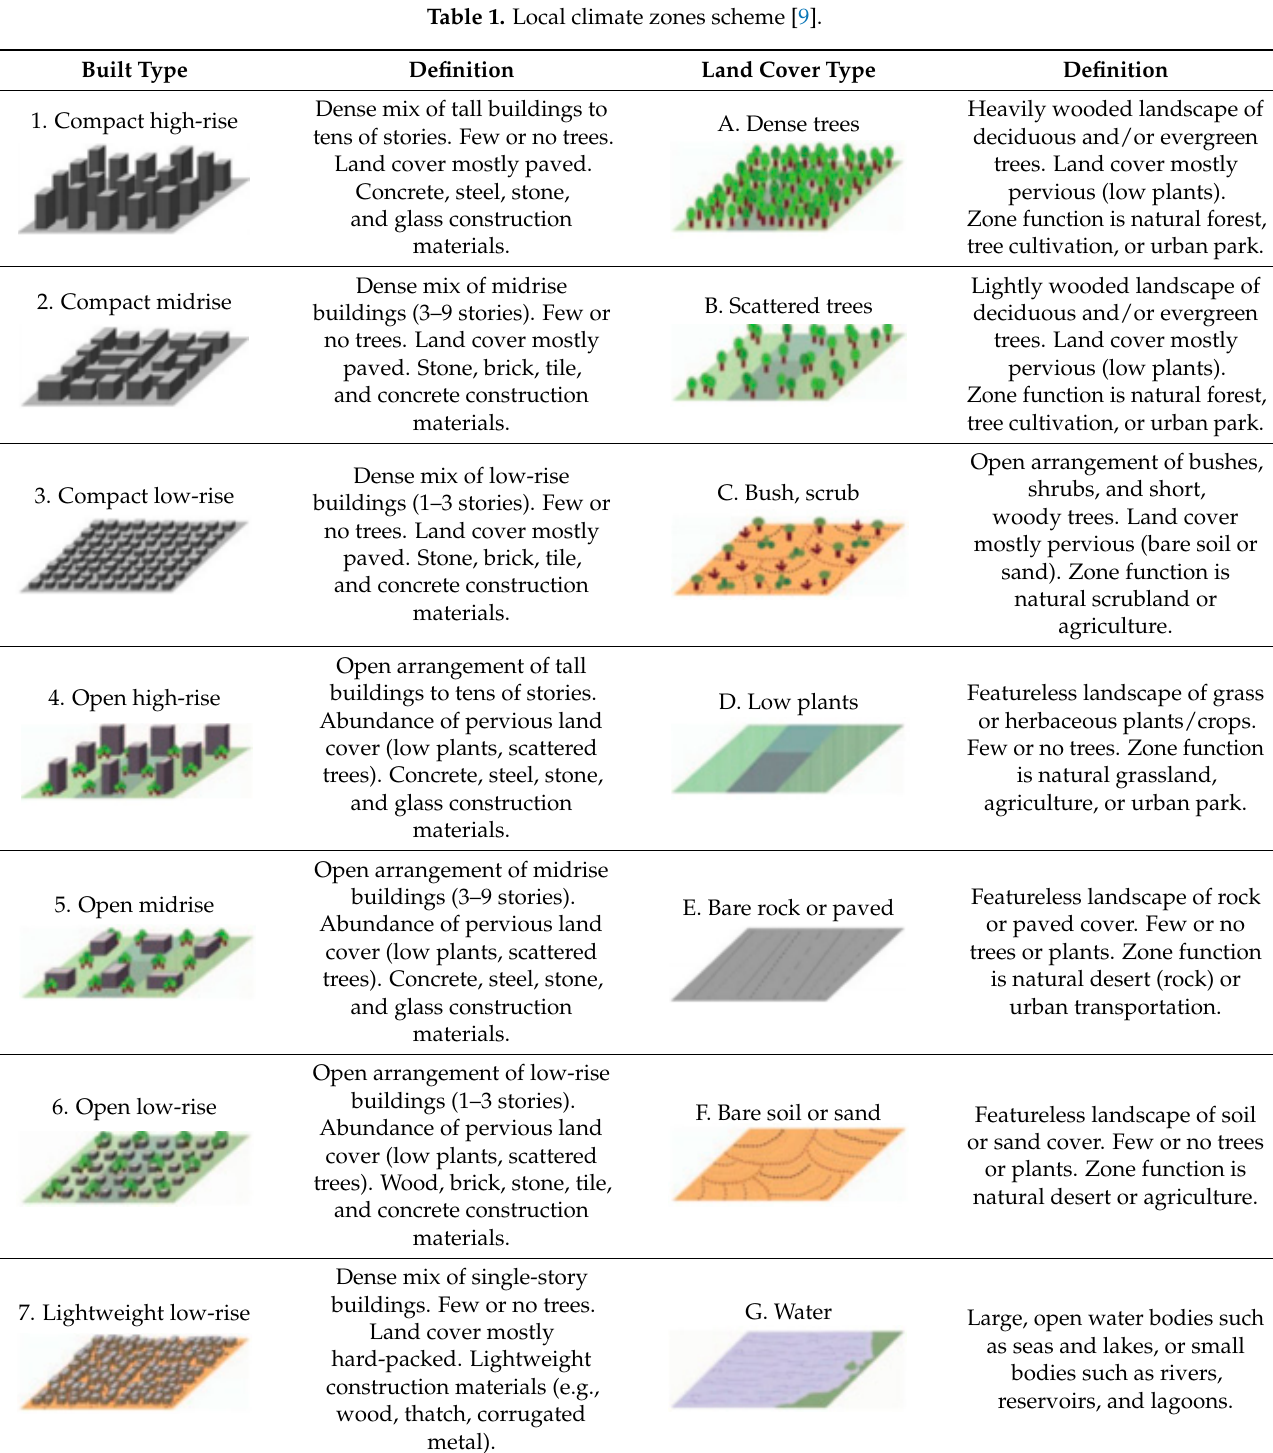
Table 1. Local climate zones scheme [9]. Table 1. Local climate zones scheme [9] . Table 1. Local climate zones scheme [9] . Table 1. Local climate zones scheme [9] . Table 1. Local climate zones scheme [9] . Table 1. Local climate zones scheme [9] . Table 1. Local climate zones scheme [9] . Table 1. Local climate zones scheme [9] . Table 1. Local climate zones scheme Table 1. Local climate zones scheme [9] . Table 1. Local climate zones scheme [9] . Table 1. Local climate zones scheme [9] . Table 1. Local climate zones scheme [9] . Table 1. Local climate zones scheme [9] . Table 1. Local climate zones scheme [9]